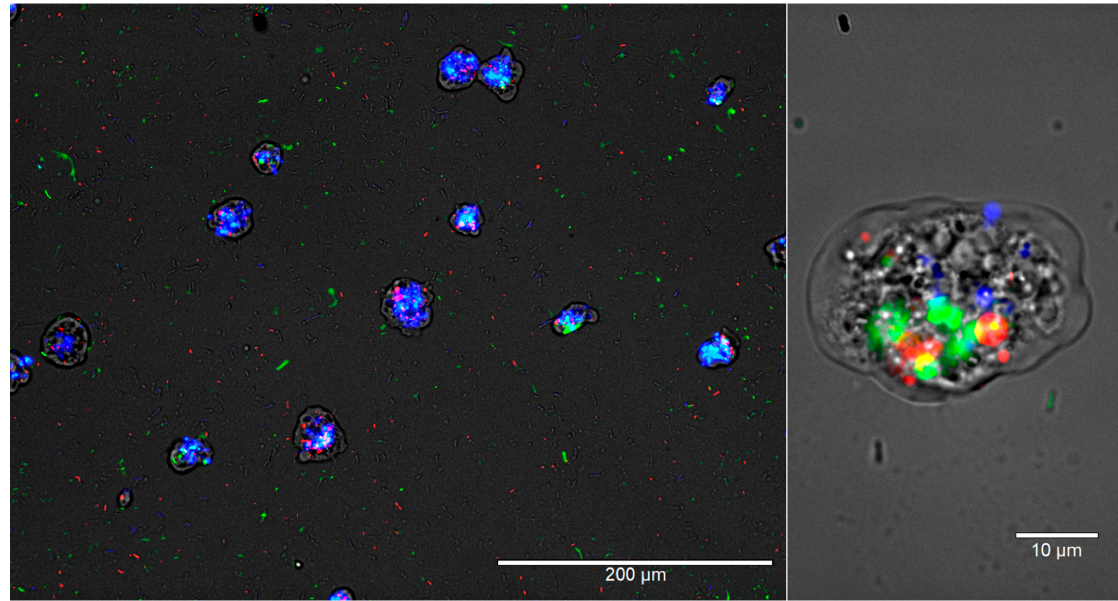
Figure 3. Intracellular L. pneumophila interferes with W. magna ’s digestion process. W. magna and L. pneumophila were co-cultured at RT, and after 24 h, E. coli TOP10 and E. coli MG1655 were added to the culture. The images represent overlaid images of the same field of view under four light channels, Monocolor transmission light channel, Green fluorescent chan- nel, Texas-Red channel, and DAPI channel at 200× and 1000× magnification after 26 h of co-culture. L. pneumophila cells are green, E. coli MG1655 cells are red, and E. coli TOP10 cells are blue in color.